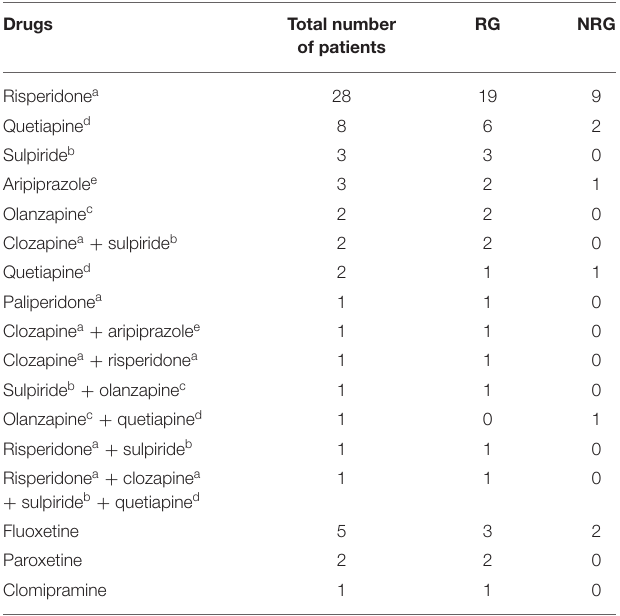
TABLE 1 | Antipsychotic and additional drugs used in FES patients.